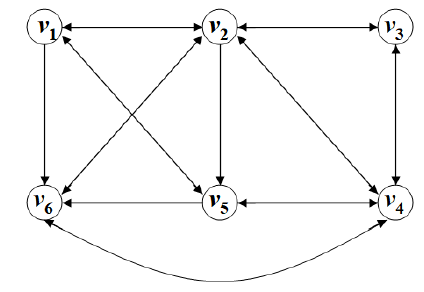
Figure 1. A directed graph G with n = 6 nodes, which is ( 2,2 )